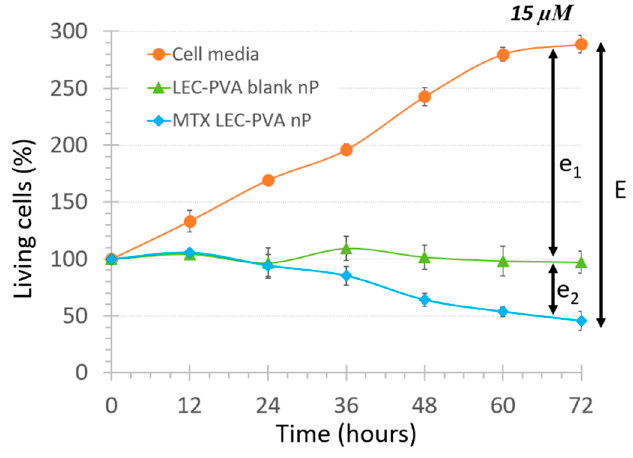
Figure 4. Total cytotoxic effect of LEC-PVA nanoparticles (nP) at 15 µ M concentration inside 100- µ m high platforms, showing the components e 1 and e 2 of term E defined in this study.